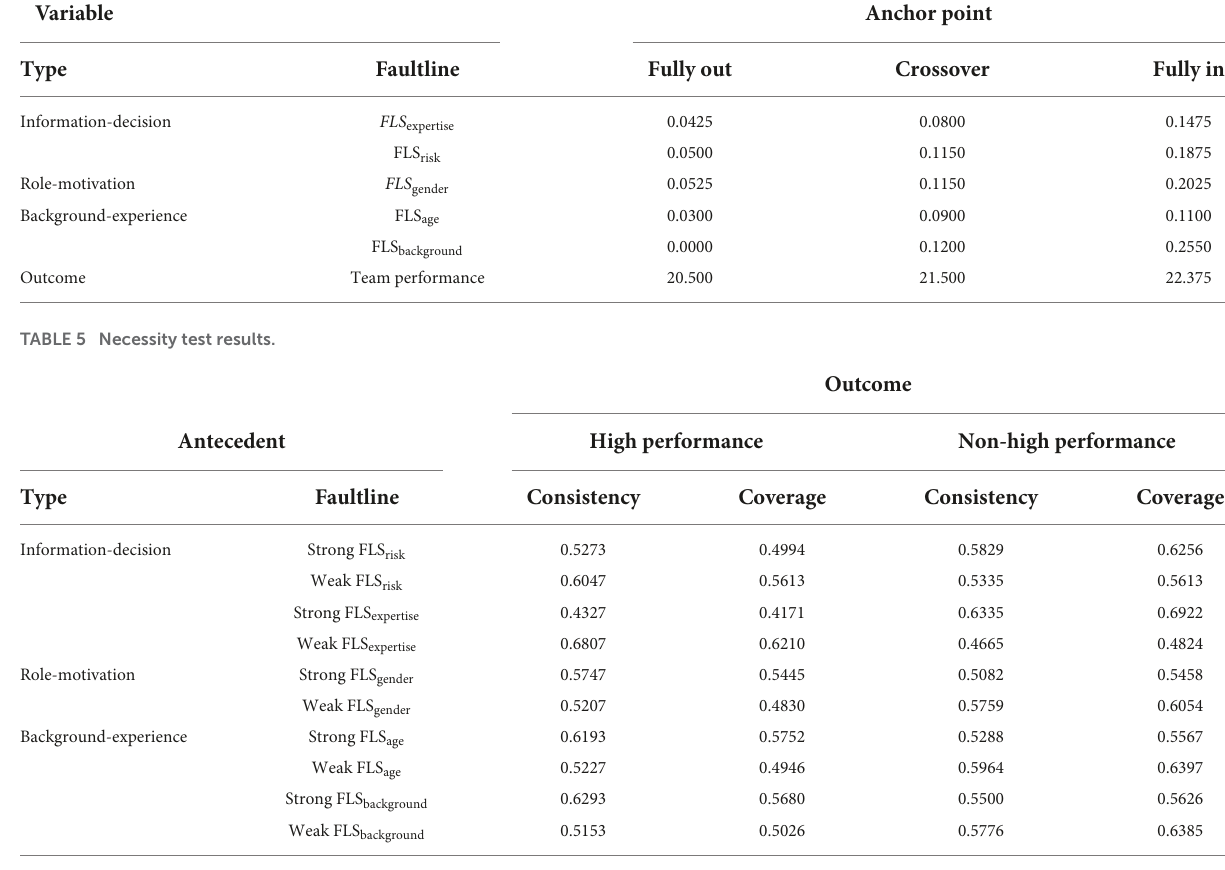
TABLE 4 Calibration anchor points of each variable.